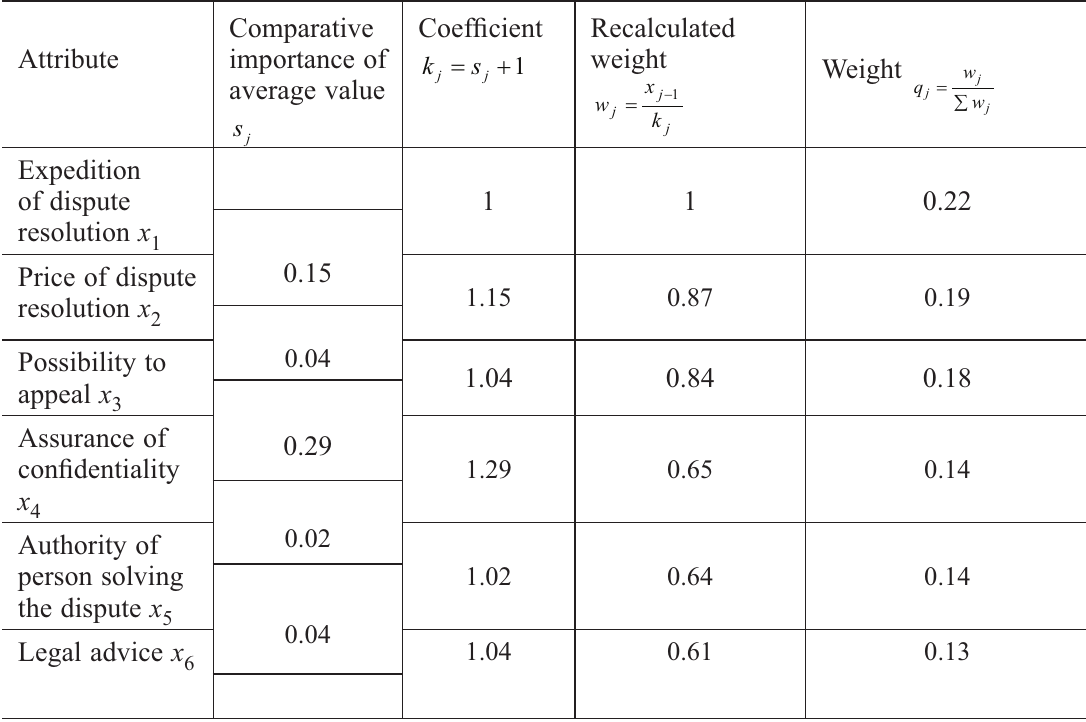
Journal of Business Economics and Management, 2010, 11(2): Table 1. Attributes Describing Resolution Methods and Their Parameters